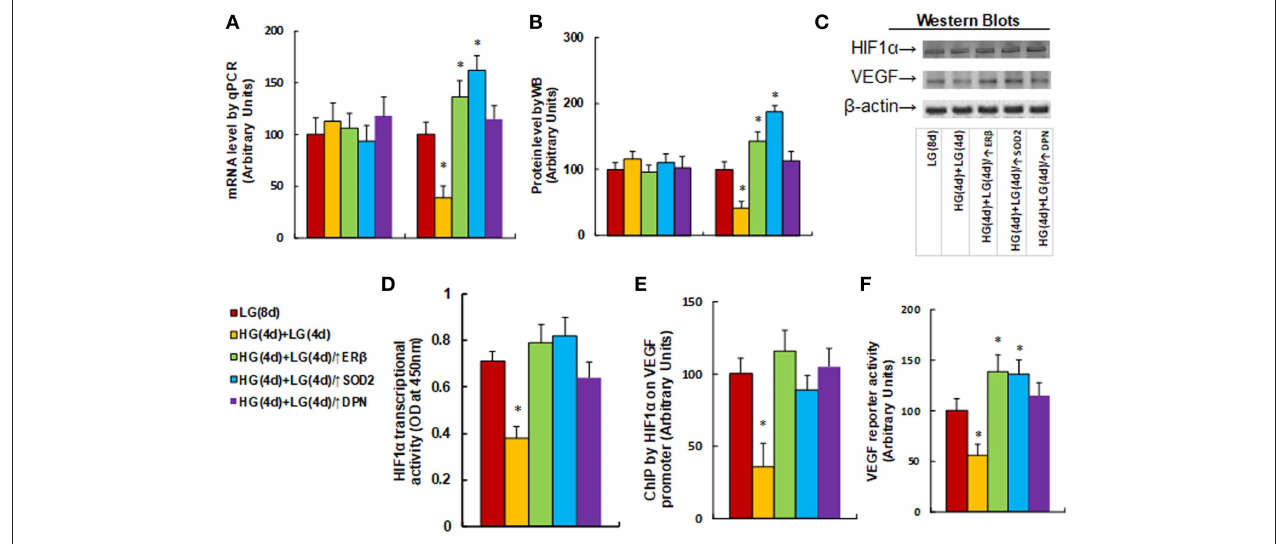
FIGURE 3 | ER β expression diminishes hyperglycemia-induced persistent suppression of the HIF1 α /VEGF signaling pathway. The HUVECs cells were cultured in hypoxia conditions and treated either in normoglycemia (5mM) for 8 days (LG(8d)), or in hyperglycemia (HG in 25mM glucose) for 4 days followed by normoglycemia (LG in 5mM glucose) for an additional 4 days (HG(4d) + LG(4d)), or the cells were infected at day 4 by either ER β lentivirus (HG(4d) + LG(4d)/ER β ↑ ), or SOD2 lentivirus (HG(4d) + LG(4d)/SOD2 ↑ ), or treated by ER β agonist (HG(4d) + LG(4d)/DPN) for subsequent 4 days, and the cells were harvested for further analysis. (A) mRNA levels by qPCR, n = 4. (B) Protein quantitation for western blots, n = 4. (C) Representative pictures for (B) . (D) HIF1 α transcriptional activity assay, n = 5. (E) ChIP analysis by HIF1 α antibody on VEGF promoter, n = 4. (F) VEGF reporter activity assay, n = 5. * P < 0.05, vs. LG(8d) group. Data are expressed as mean ±